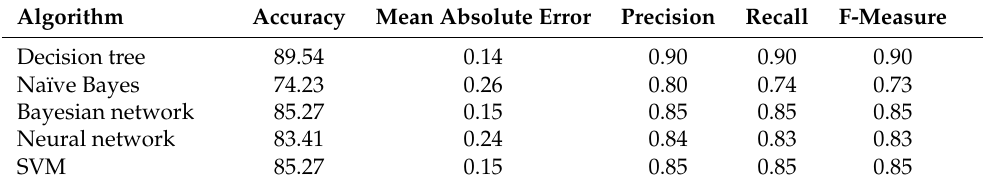
Table 9. Case study 2 results for PCA dimension reduction approach using percentage split.